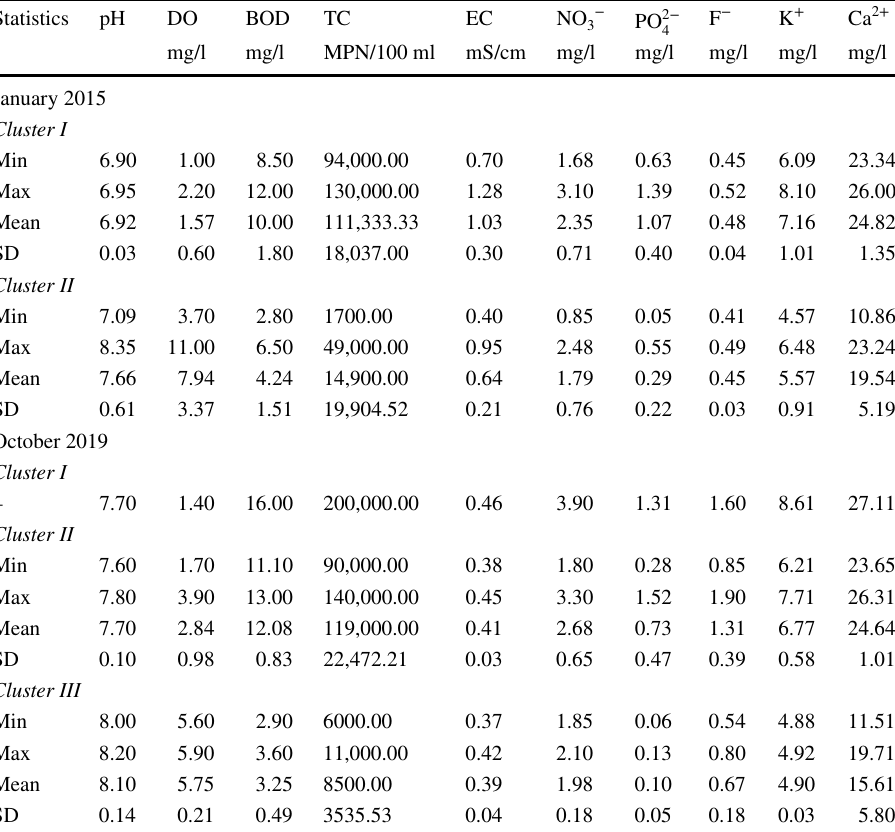
Table 1 Descriptive statistics for clusters obtained through